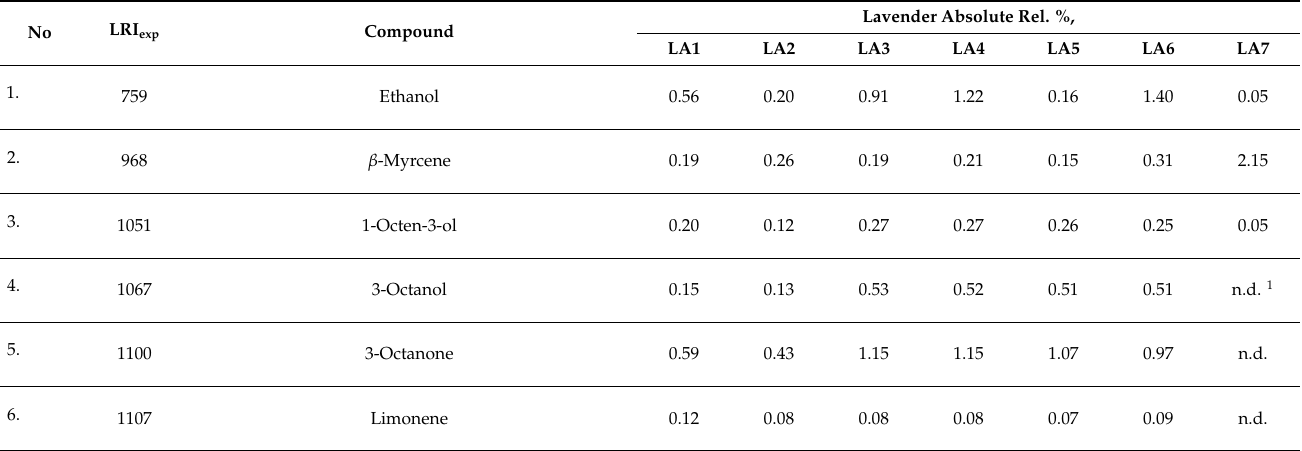
Figure 1. Representative GC/MS (TIC) chromatograms of LA samples: ( a ) LA6; ( b ) LA7. The main compounds found in Las are as follows: 2. β -myrcene, 4.3-octanol, 8. cis- β -ocimene, 9. tran s- β -oci- mene, 12. linalool, 15. lavandulol, 16. 4-terpineol, 21. linalyl acetate, 22. lavandulyl acetate, 27. nerolidol, 28. trans - β -caryophyllene, 29. geranyl acetate, 30. trans- β -farnesene, 6. caryophyllene ox- ide, 37. coumarine, 43. 7-methoxy-coumarine. The numbers of the compounds correspond to the numbering in Table 1. Table 1. Chemical composition (compounds with concentration >0.1%) of LA samples, as determined by GC/MS/FID on a DB-17HT column.